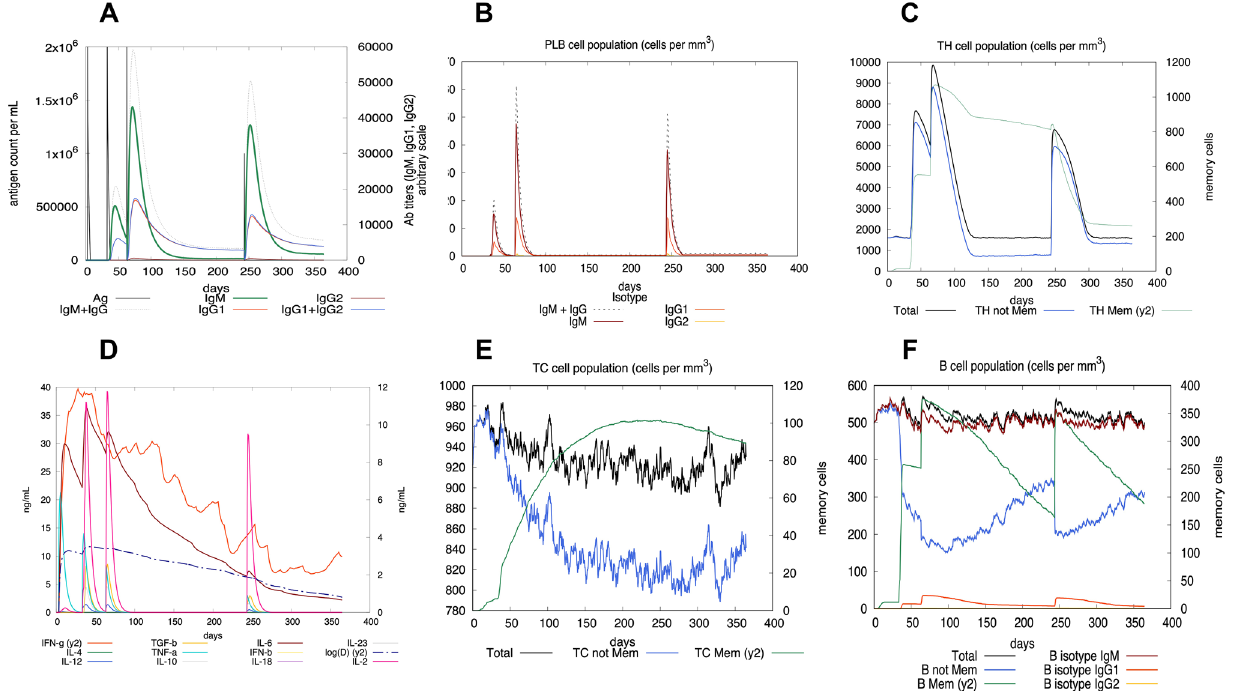
Figure 11. In silico simulation of immune response using vaccine as an antigen. ( A ) Antigen and immunoglobulins. ( B ) Plasma B cells. ( C ) TH cell population. ( D ) Cytokines and interleukins. ( E ) CTL population. ( F ) B cell